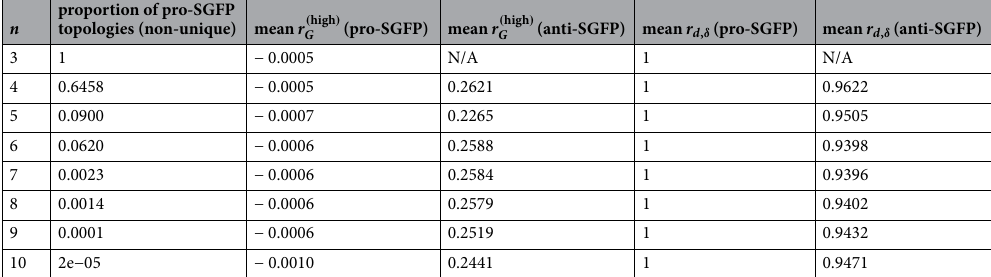
Table 1. For n = 3, 4 . . . 10 , we used the G n , 1 graph generator to find 100,000 instances of non-regular 2 connected networks for each n . The table describes what proportion of those is pro-SGFP for each n ; the correlations that may fail SGFP for pro- and anti-SGFP graphs for each n ; and the degree-delta correlation r d , δ for the two